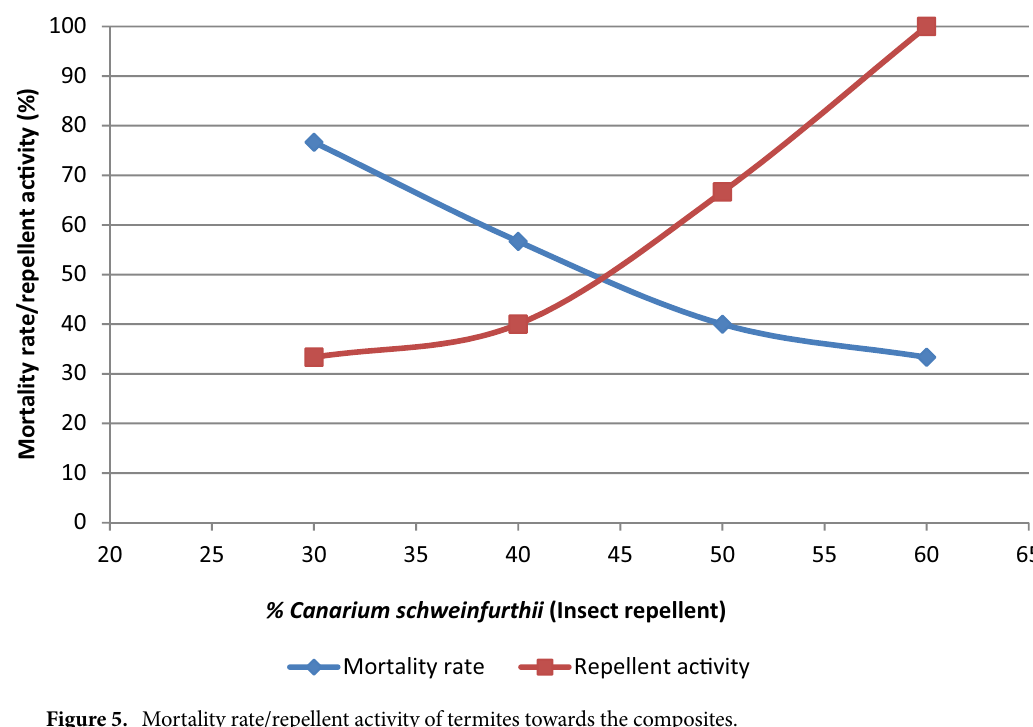
Figure 5. Mortality rate/repellent activity of termites towards the composites.